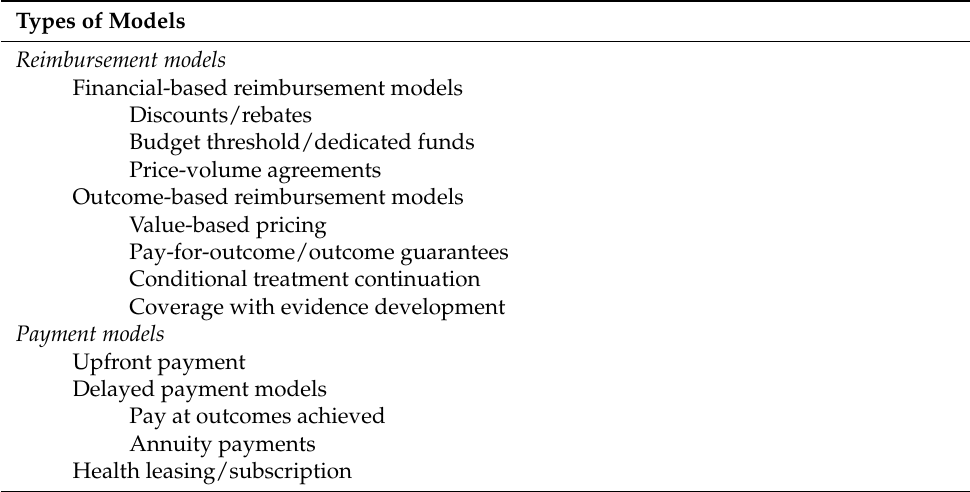
Table 1. Included reimbursement and payment